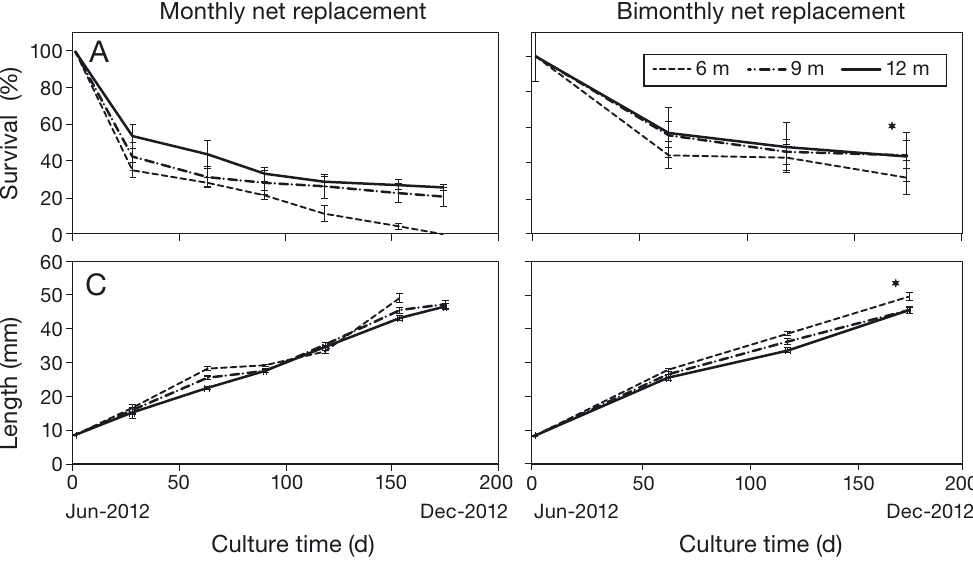
Fig. 4. Mean ± SE (A) sur- vival and (B) growth in shell length of Nodipecten nodosus maintained at dif- ferent conditions (i.e. cul- ture depths and net re- placement frequencies). *p <